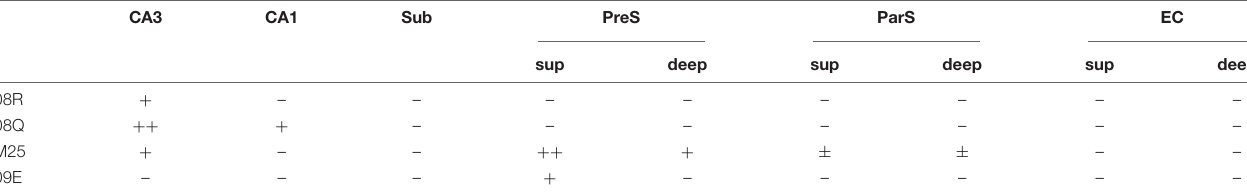
TABLE 4 | BDA injection sites and relative amount of tracer taken up in the hippocampal and parahippocampal areas of each experimental